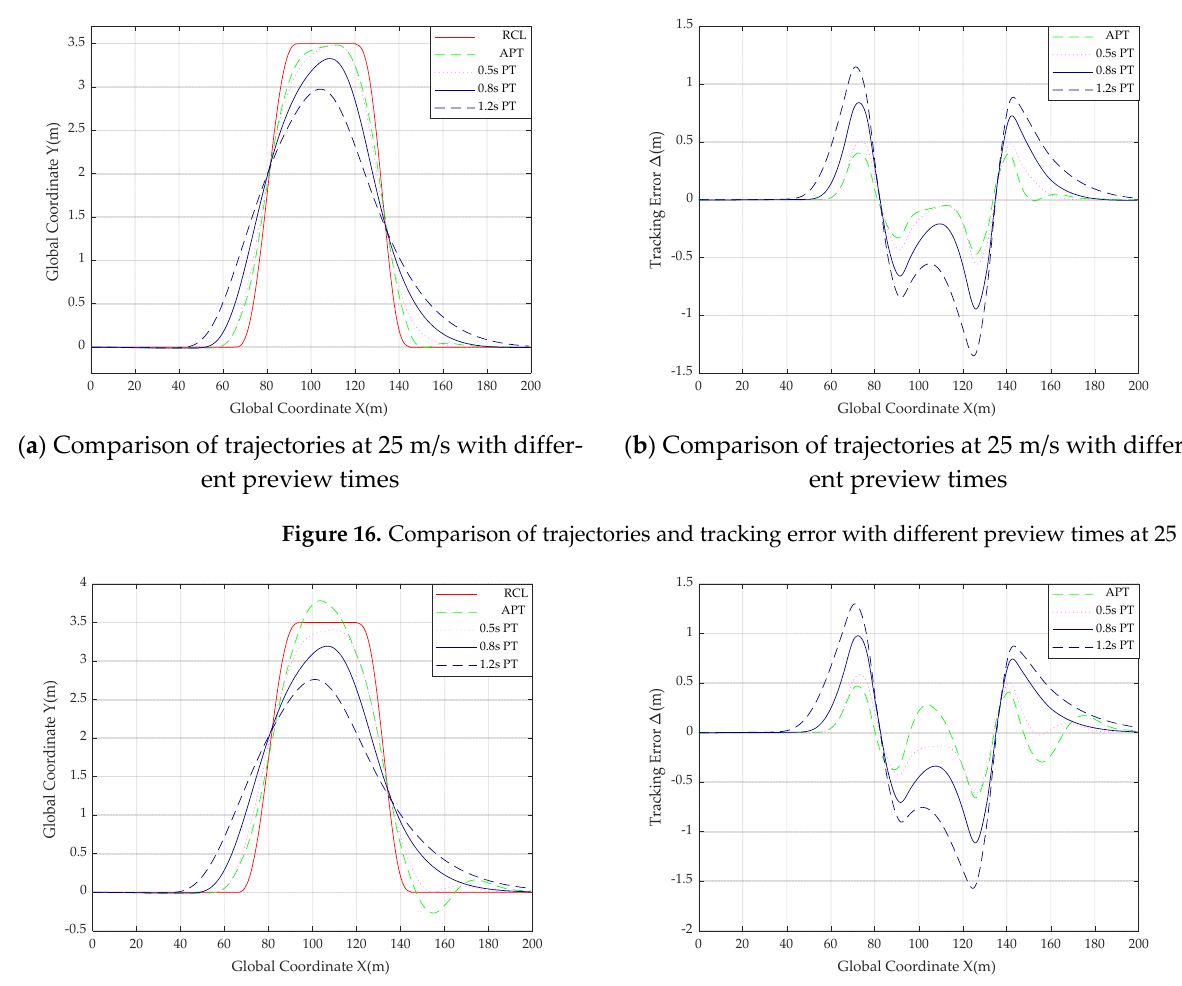
( a ) Comparison of trajectories at 30 m/s with differ ‐ ( b ) Comparison of trajectories at 30 m/s with differ ‐ ent preview times ent preview times Figure 17. Comparison of trajectories and tracking error with different preview times at 30 m/s.